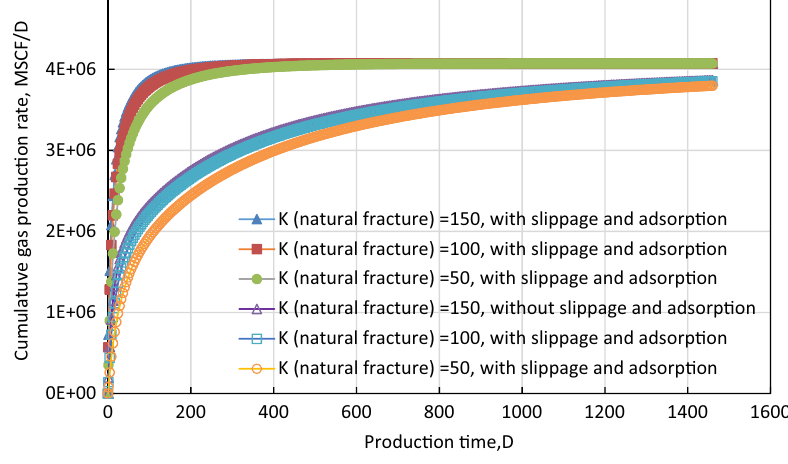
Fig. 8 Performance of dual- permeability shale gas reservoir with different ratio of natural fracture to matrix